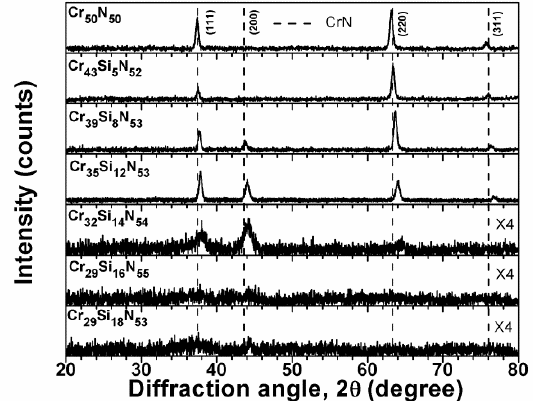
ff raction (XRD) patterns of as-deposited Cr–Si–N coatings ( × 4: multiplied by Figure 1. X-ray diffraction ( XRD) patterns of as-deposited Cr–Si–N coatings (×4: multiplied by 4). Figure 1. X-ray di